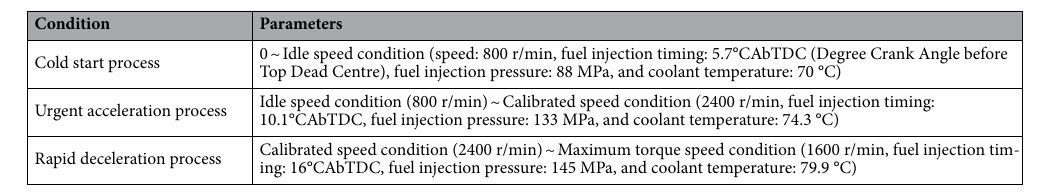
Table 3. Test and test